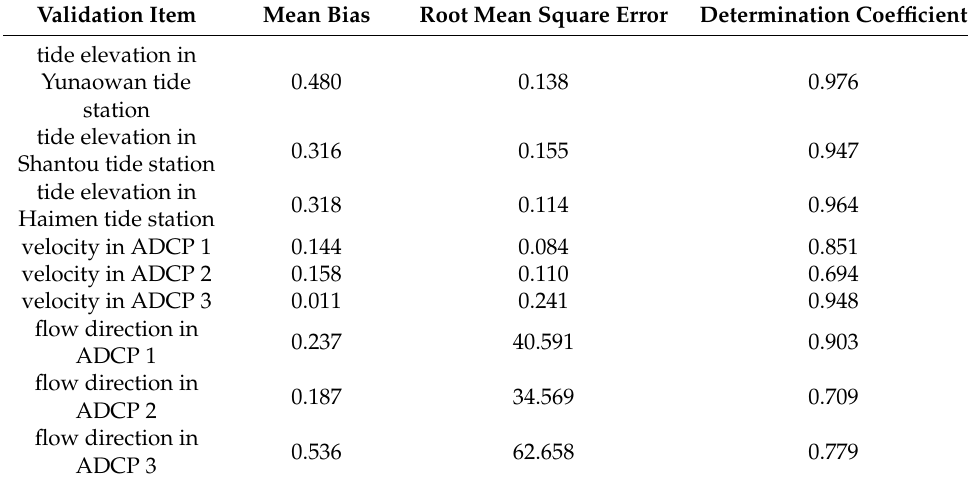
Table 3. Error analysis between model data and measured